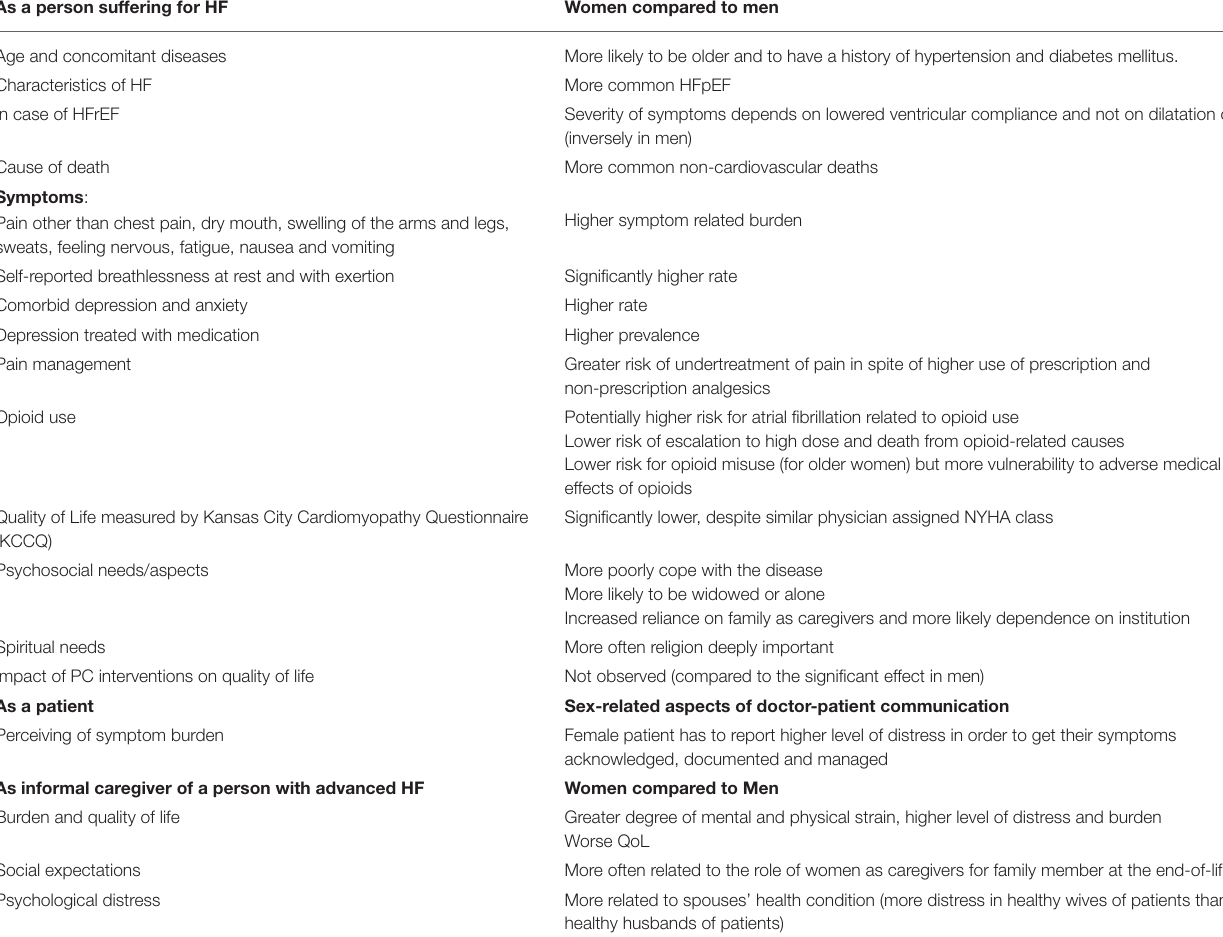
TABLE 2 | Differences between women and men in relation to PC for people living with HF. As a person suffering for